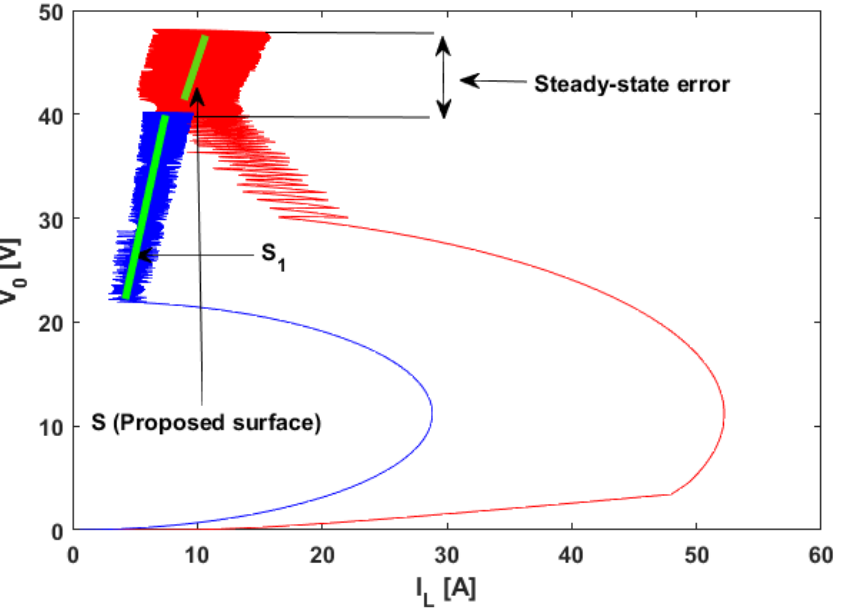
Figure 8. The motion of state variables on the proposed surface and S 1